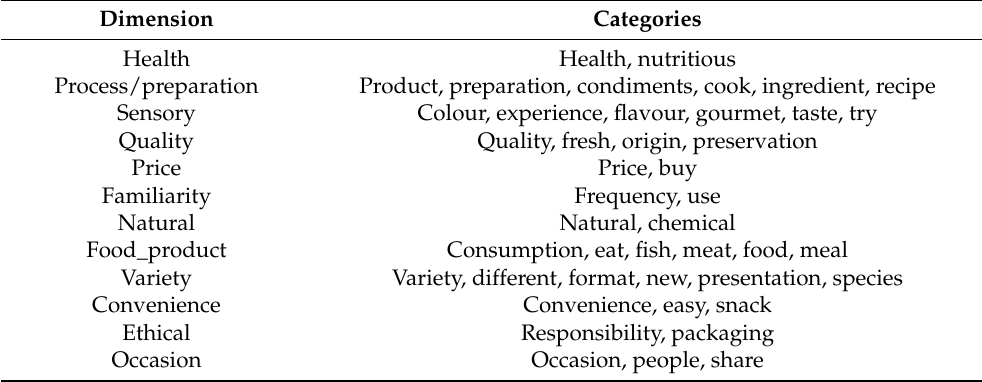
Table 2. Dimensions formulated by the grouping of the 44 categories through the second pseudo- triangulation